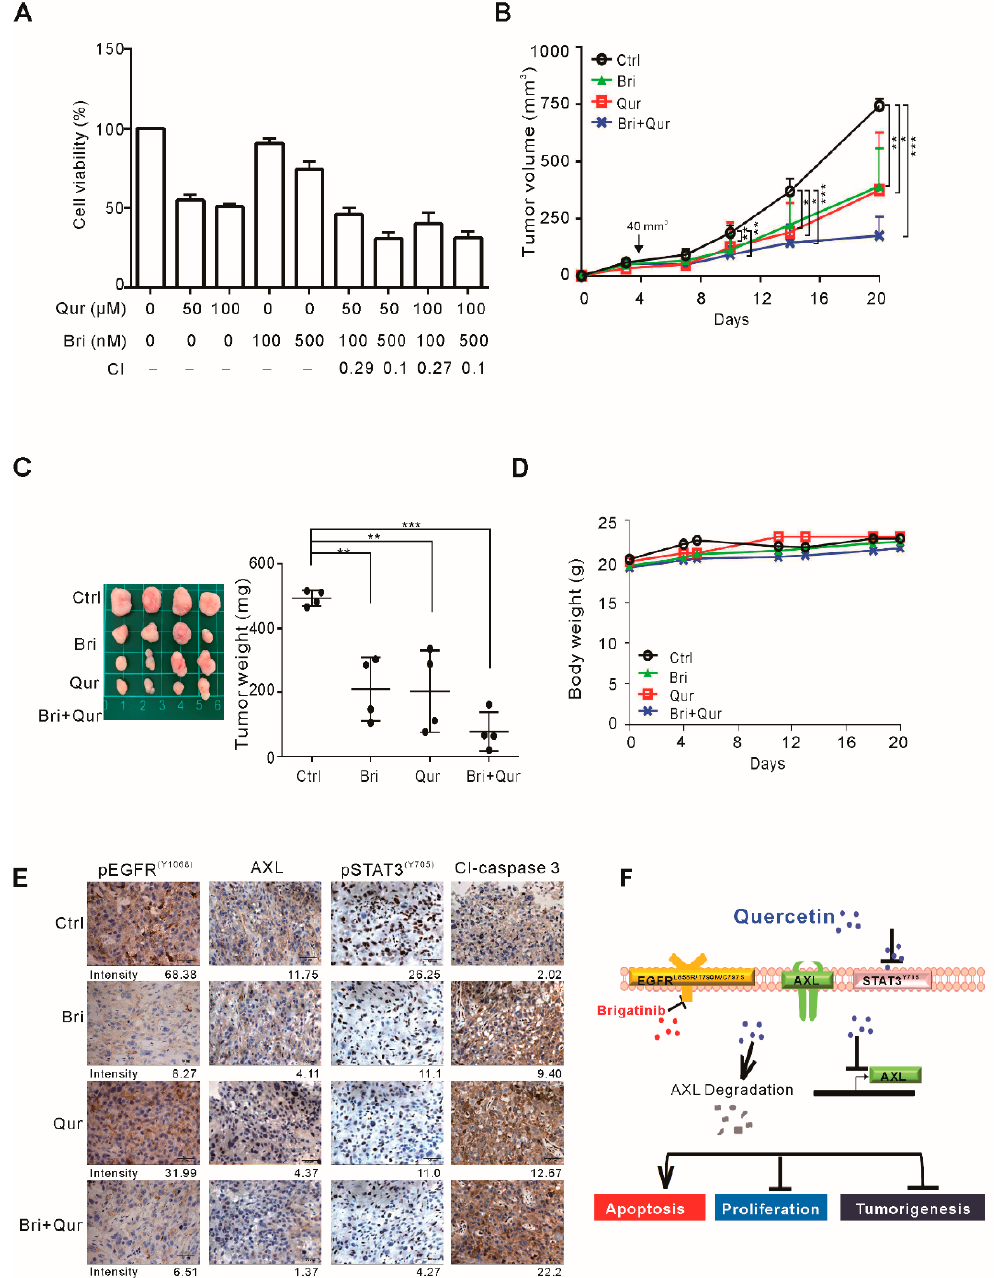
Figure 4. Effects of quercetin and brigatinib on the growth of H1975-MS35 cells in vitro and in vivo. ( A ) H1975-MS35 cells were treated with various concentrations of quercetin and/or brigatinib for 24 h. The viability of the treated cells was determined with trypan blue staining assays. The data are presented as the mean ± SD. Combination index (CI) values are shown at the bottom. ( B – D ) H1975-MS35 cells were injected subcutaneously into the flank of each mouse. When the tumor volumes reached approximately 40 mm 3 , the mice were treated with vehicle control, 25 mg/kg brigatinib, or/and 50 mg/kg quercetin once daily (n = 4 per group). The tumor volumes were measured three times a week and are shown in ( B ). The tumors were excised from the mice at the end of the experiment (20 days) and are shown in ( C ). The body